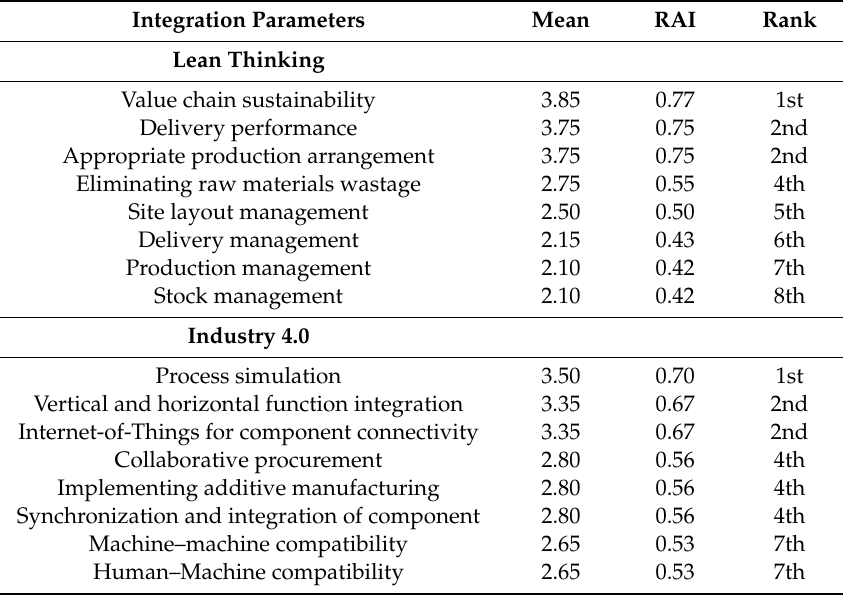
Table 21. Parameters for e ff ective integrating of lean thinking approach and Industry 4.0. Integration